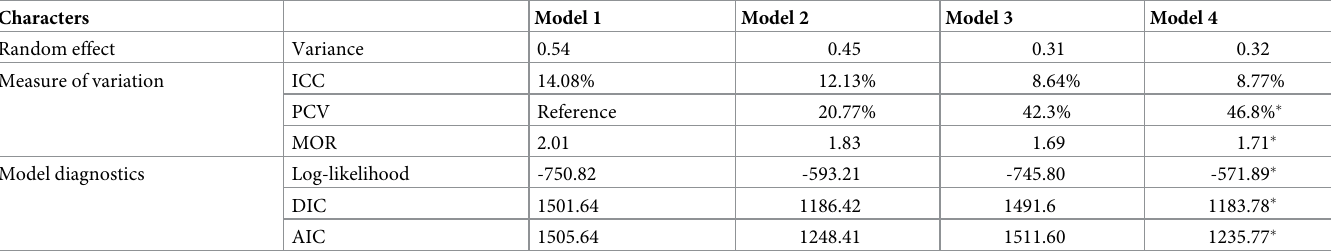
Key : Model 1 (null model) = without independent variables, Model 2 = only individual- level variables, Model 3 = only community- level variables, Model 4 = both individual and community level variables, PCV = Proportional Change in Variance, ICC = Intra Class Correlation, MOR = Median Odds Ratio, AIC = Akaike Information Criteria, DIC = Deviance Information